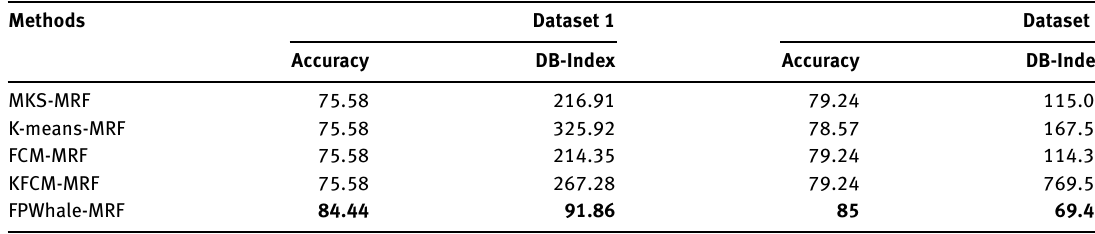
Table 4: Performance Comparison Based on Minimum